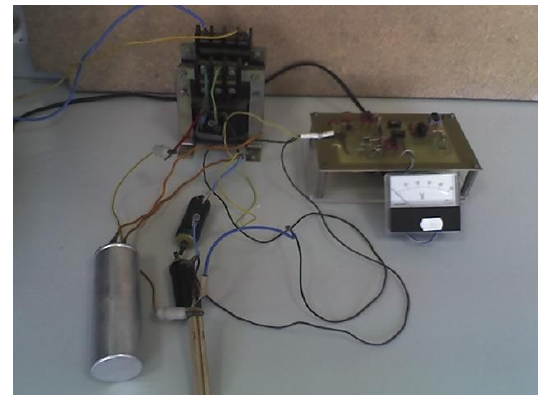
Figure 10. Liquid CO-level sensor: experimental version.